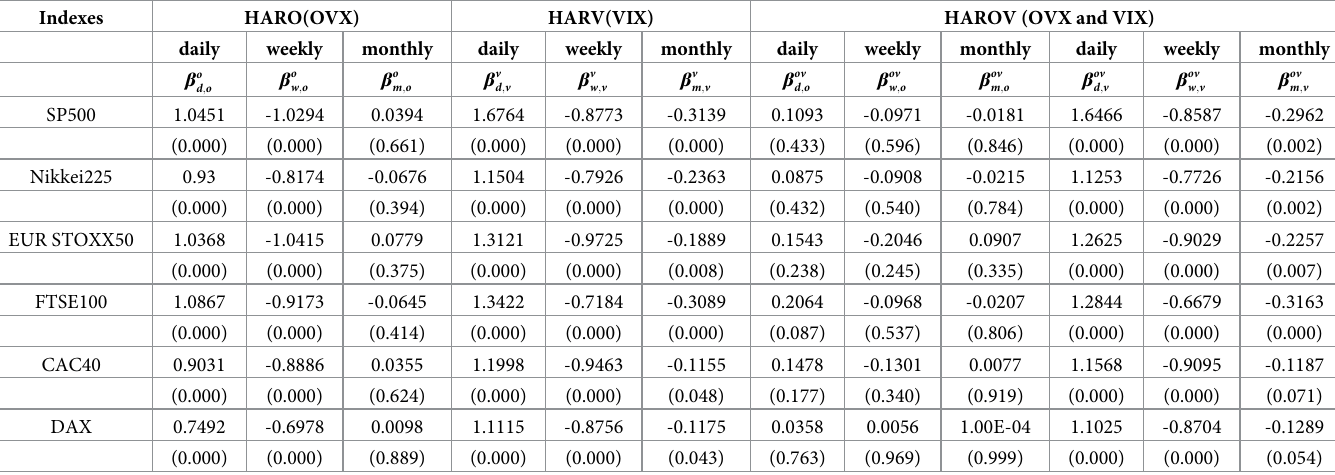
Table 1. Full sample estimations of HARO, HARV and